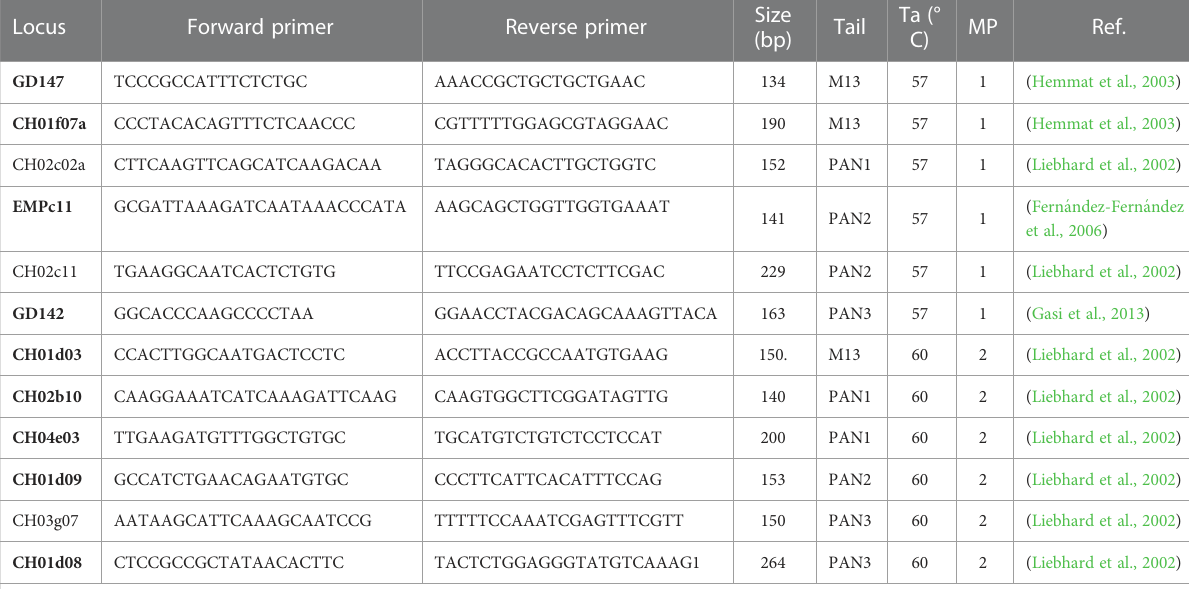
TABLE 1 List of the selected primer pairs.